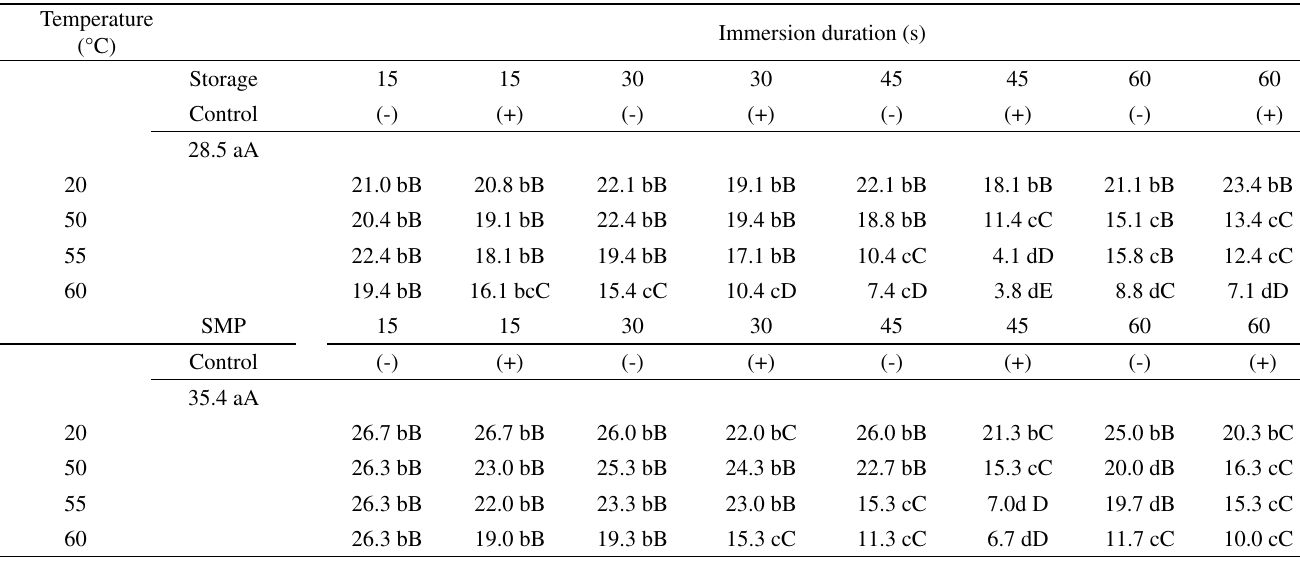
(z) Values are means with N=90 each time. Capital letters relate to comparisons within rows, lower case letters to comparisons within columns, dif- ferent letters indicate differences at P ≤0.05 according to Newman-Keuls